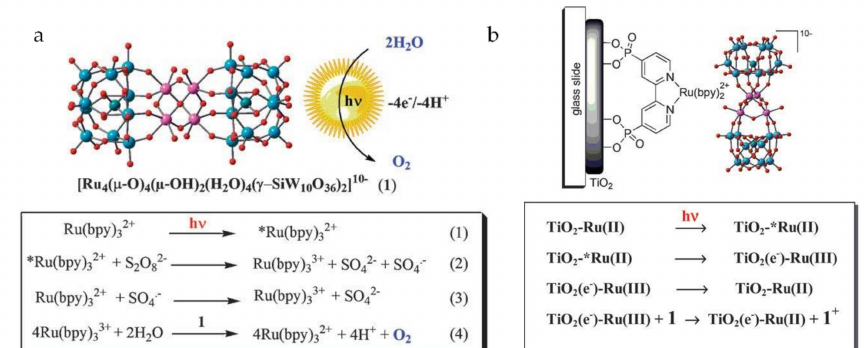
Figure 3. ( a ) Water oxidation by photogenerated Ru(bpy) 33+ , using 1 as catalyst and persulfate as sacrificial electron sink. ( b ) Reaction of catalyst 1 with Ru (III) species photogenerated by electron injection into nanocrystalline TiO 2 layer [81].